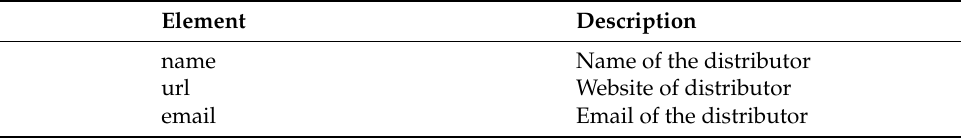
Table A3. JSON describing the distributor of the